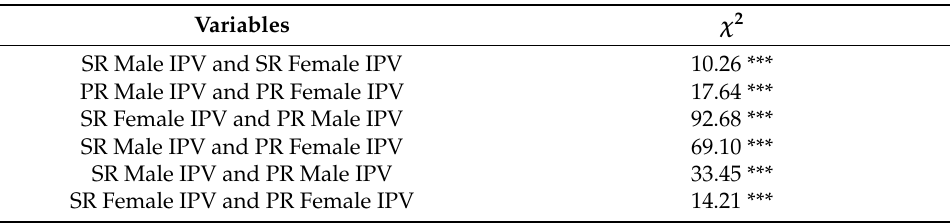
Table 6. Chi-square tests of independence results for IPV variables.